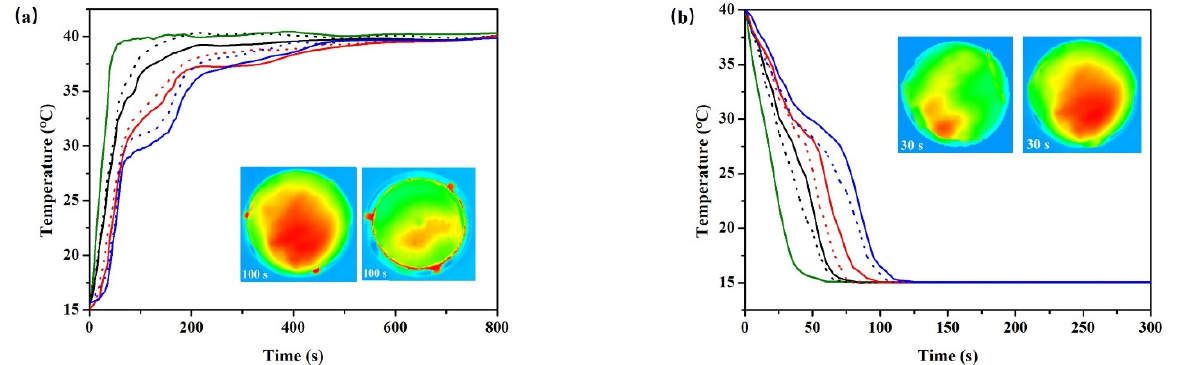
Figure 10. Time-dependent changes in surface temperature of functional textile under heating ( a ) and cooling ( b ) processes. Solid curves represent functional fabric before washing cycles. Dashed curves represent functional fabric after 10 washing cycles. (Green: original fabric, Black: FT10, Red: FT20, Blue: FT30; the relevant thermographic images of original fabric and FT30 were